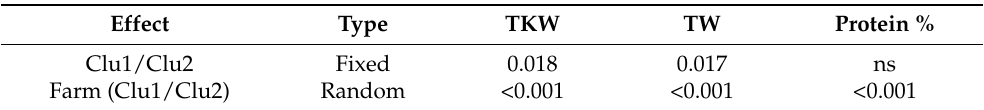
Table 1. Significant p -values from ANOVA F-tests, for each phenotypical trait analyzed from Solina samples collected in 2018 in Abruzzo.